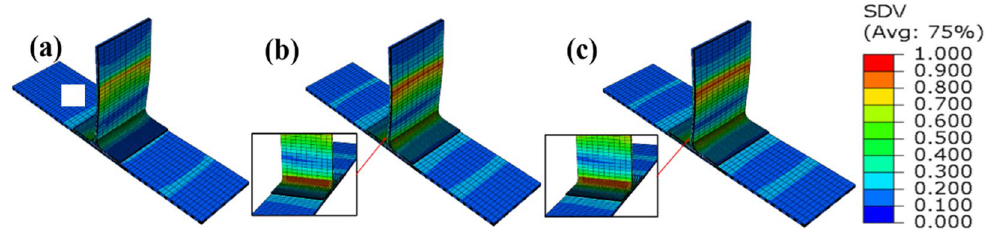
Figure 9. Failure modes of side bending material with defect: ( a ) fiber failure; ( b ) matrix failure; ( c ) fiber- matrix shear failure (ABAQUS 6.14, https:// www. 3ds. com/ produ cts- servi ces/ simul ia/ produ cts/ abaqus) 43 .